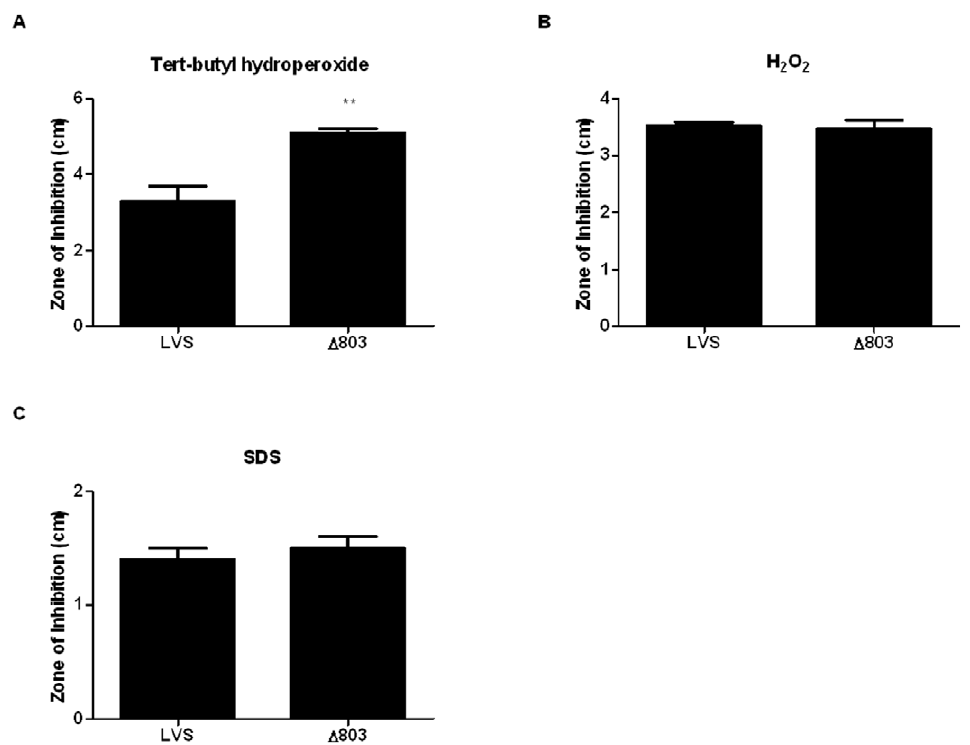
Figure 8. The FTN_1133 ortholog, FTL_0803 , confers resistance to tert-butyl hydroperoxide. Twenty-five mM tert-butyl hydroperoxide (A), 3% hydrogen peroxide (B), and 200 mg/ml SDS (C) were spotted on filter disks placed on lawns of wild-type LVS or the FTL_0803 mutant ( D 803), incubated overnight, and then the zones of inhibition for each were measured. In each experiment, bars represent the mean and error bars represent the standard deviation (n=3). Data shown is representative of at least three independent experiments. Asterisks indicate significance as compared to wild-type. (**) p , 0.005.